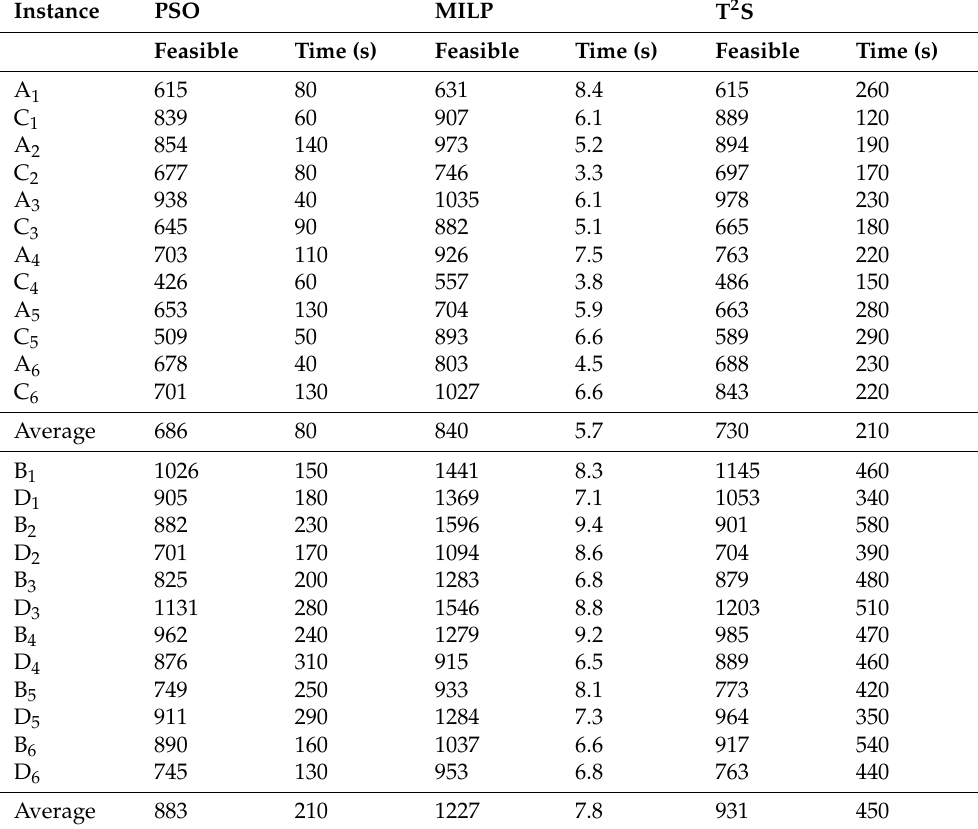
Table 3. Comparison of PSO to MILP and T 2